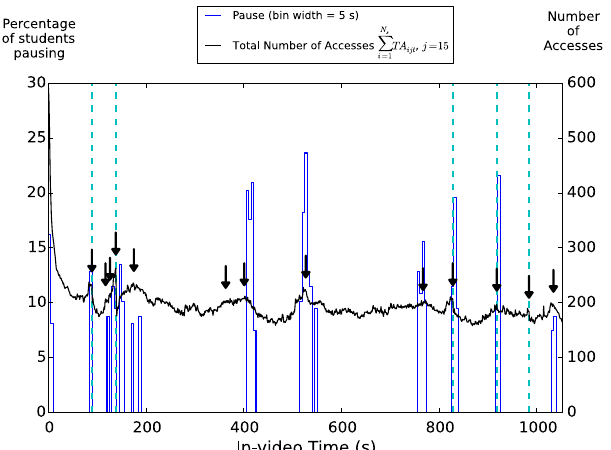
FIG. 6. Clickstream analysis of video 15. This video, entitled “ Creating a Computer Model of Constant Velocity Motion, ” was accessed by 148 unique students in total. The black line represents the number of times each particular point of a given P N s j ¼ 15 ). video was accessed by students (i.e., i ¼ 1 TA ijt , where The blue line represents the percentage of unique students who has ever paused within each 5 s time window. If multiple pauses were made by the same student within a 5 s window, this student was counted only once in the given window. Since we are pauses both at the interaction points and the very end of the video have been taken out. In order to help identify peaks, pauses are not plotted for all the 5 s time windows. Instead, only cases for